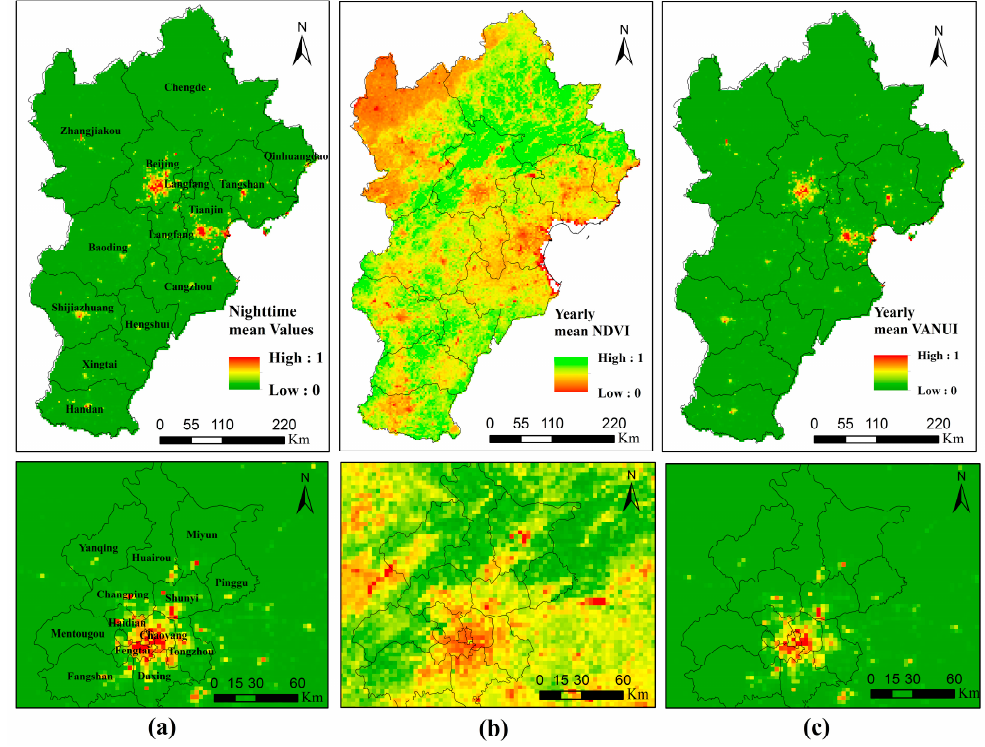
Figure 2. Images of mean annual values of the VIIRS NTL data ( a ), NDVI ( b ), and VANUI ( c ) for the BTH region.